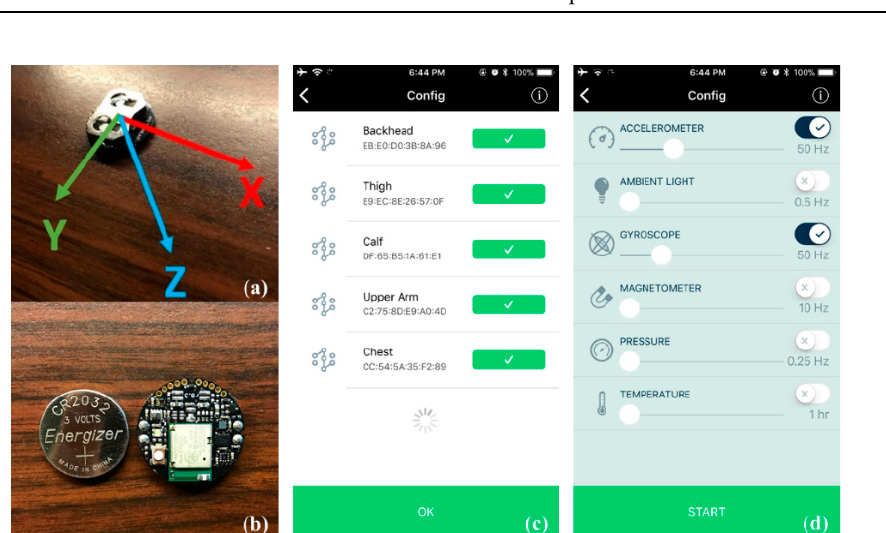
Figure 1. MetaMotion C sensor and interfaces [5]: ( a ) MetaMotion C IMU sensor board with the